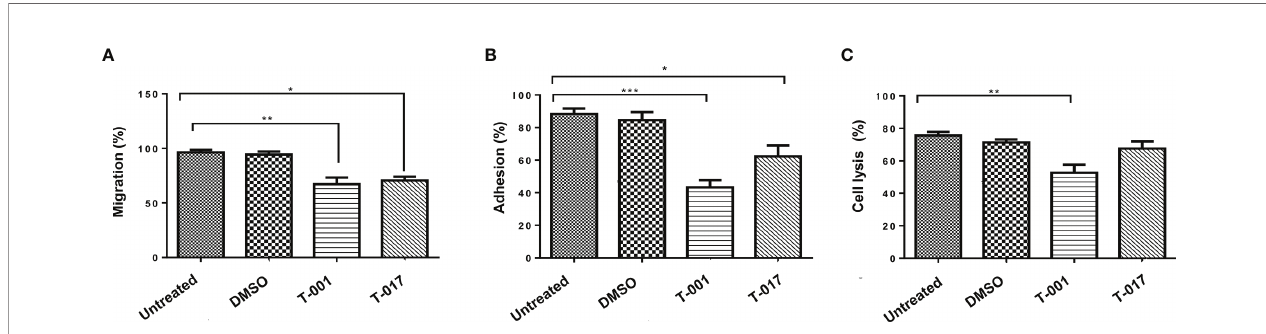
FIGURE 3 | Effect of T-001 and T-017 on migration (A) , adhesion (B) and cytolytic activity (C) of ( E ) histolytica trophozoites. Trophozoites were previously treated with T-001 or T-017 as described. (A) Trophozoite migration was determined after 3 h incubation in transwell chambers and cell counting; migration was expressed as percentage. (B) Trophozoites were seeded on SW-480 epithelial cell monolayer during 15 min, adhesion were determined and expressed as percentage. (C) SW- 480 cell monolayers were incubated with E. histolytica trophozoites for 45 min; damage to the SW-480 cell monolayer was evaluated by the release of the LDH enzyme to the culture medium and (absorbance at 492nm) expressed as percentage; the histogram shows the average percentage of destruction of the SW-480 monolayers. Trophozoites treated with DMSO 0.01% and grown in standard condition were used as controls. Graphs show the mean ± standard error of three independent experiments. The comparisons between groups were carried out with the one way ANOVA test, p < 0.05 (*), p < 0.01 (**), p < 0.001